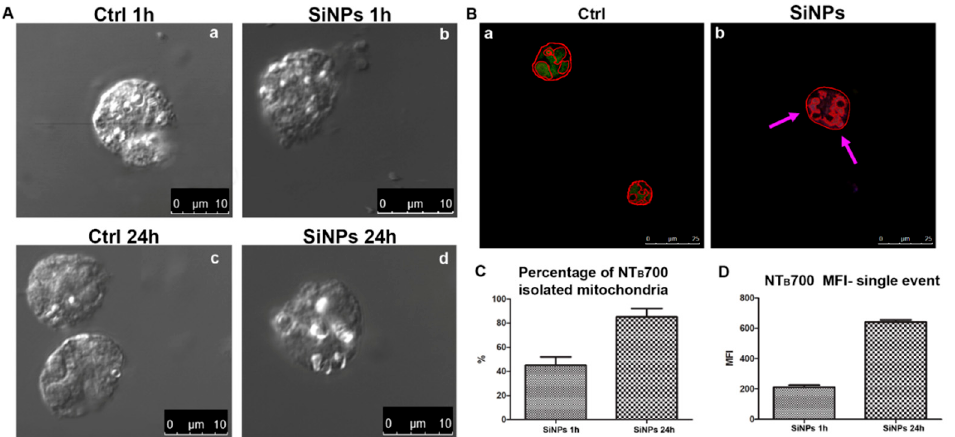
Figure 1. Isolated mitochondria of U937 cells incubated for 1 or 24 h with SiNPs. ( A ) Representative brightfield images of isolated mitochondria from controls (1 h and 24 h, a and c ) and NP-treated cells (1 h and 24 h, b and d ). Scale bar = 10 µ m. ( B ) Representative fluorescent merged confocal images of isolated mitochondria from control ( a ) and NP-treated cells ( b ) for 24 h and then stained with LTG (green) and TMRE (red). Yellow/green and violet indicate colocalization (highlighted in treated cells from violet arrows). Scale bars: 25 µm. ( C ) Histogram of flow cytometry data indicating percentage of SiNPs positive cells after 1 h and 24 h of incubation. ( D ) Histogram of flow cytometry data which illustrate mean fluorescence intensity (MFI) of SiNPs within isolated mitochondria of U937 cells after 1 h and 24 of treatment. At least 10,000 events were analyzed by flow cytometry for each experimental condition.